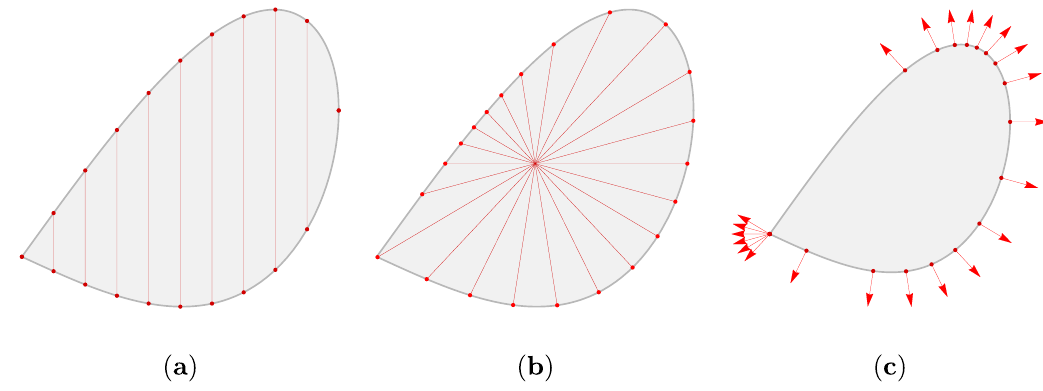
Figure 5 . Di(cid:11)erent maximization functionals to obtain the boundary of a certain region of the plane. In panel ( a ) we (cid:12)x one of the coordinates and maximize/minimize the other. In the second panel ( b ) we (cid:12)x a particular direction and perform a radial maximization, which useful for de(cid:12)ning the faces of the convex space. Finally in ( c ) we have the normal maximization where we have a uniform distribution of unit vectors and the maximization chooses the points where the normals are aligned with the unit vectors, resulting in a higher concentration of points in high curvature